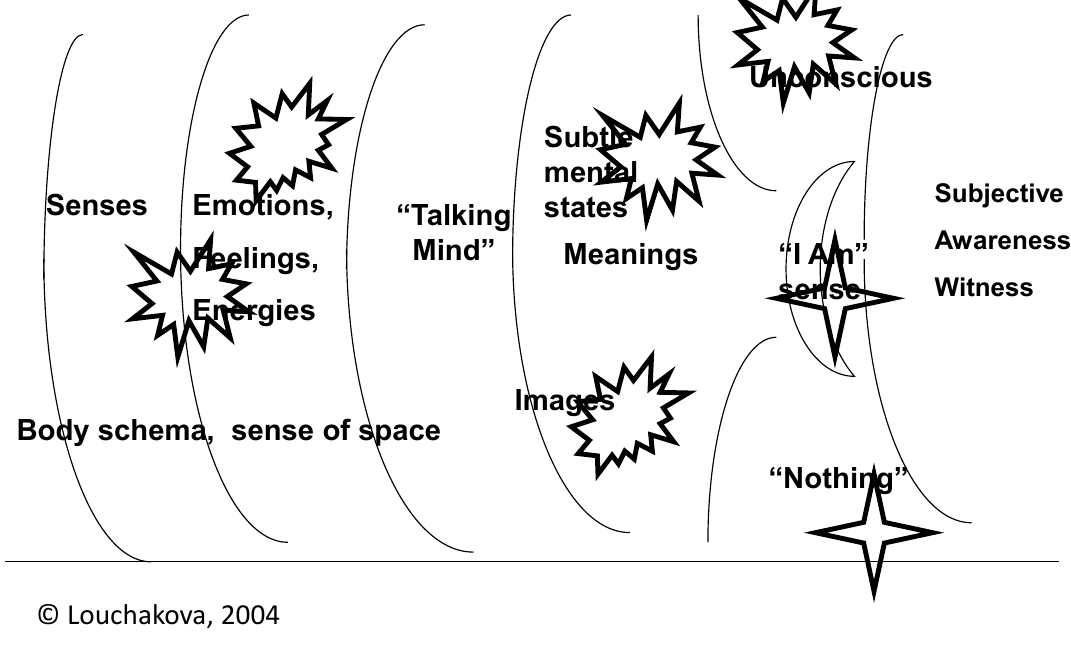
Figure 1. Areas of religious experience in the introspective space within embodied subjectivity.